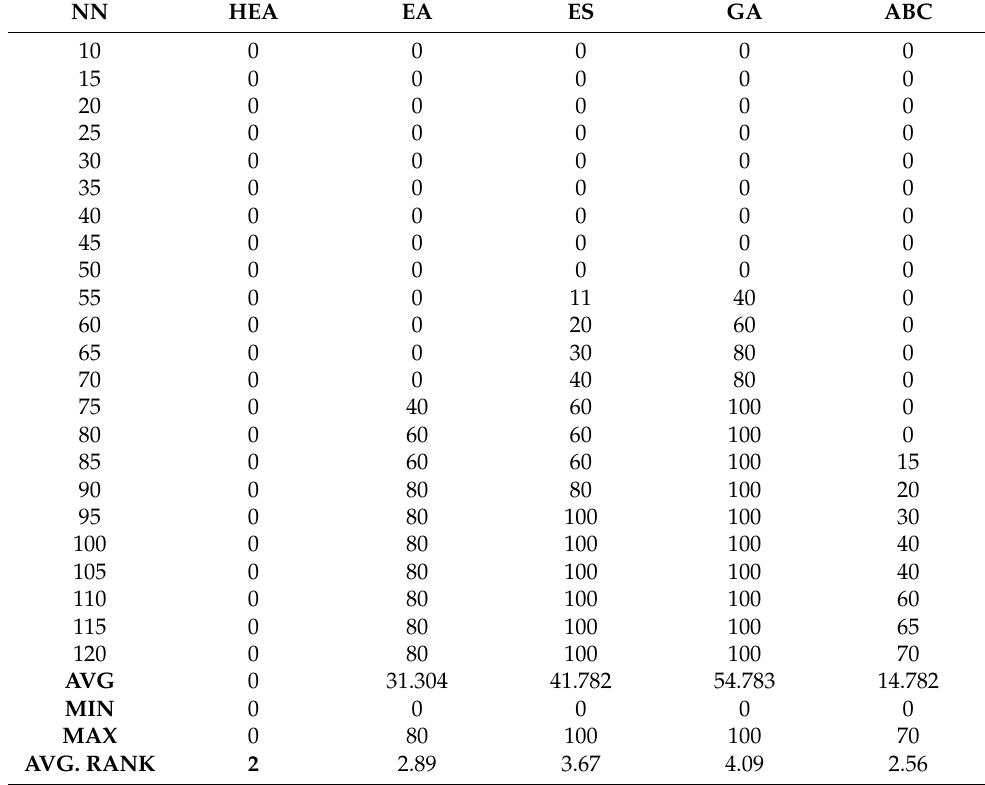
Table 7. Tabulated MAE -Testing values for different DHNN-RAN k SAT